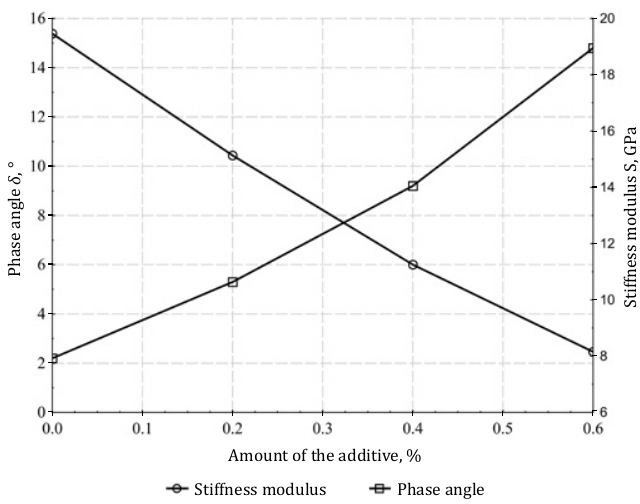
Amount of the additive, Figure 19. The effect of rejuvenator on the stiffness modulus and phase angle